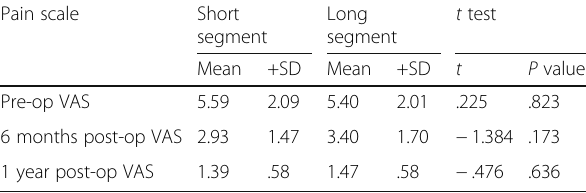
Table 3 The changes in the VAS during the follow-up period Pain scale